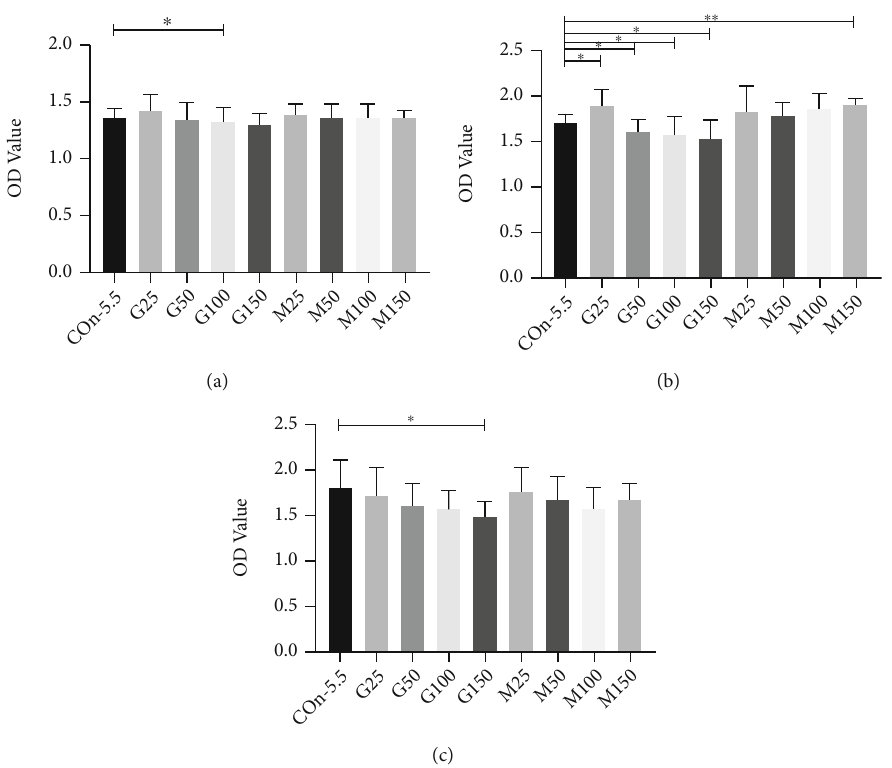
Figure 5: Cell viability of RCGs by the CCK-8 assay. Compared to the control group, the OD value was signi fi cantly lower in the G50, G100, and G150 at 48 h. (a – c) Cell proliferation ability in RGCs treated with di ff erent groups at 24, 48, and 72h. Con-5.5, G25-G150: concentration of glucose (5.5, 25, 50, 100, and 150 mmol/l, respectively); M25-M150: concentration of M-mannitol (19.5, 44.5, 94.5, and 133.5mmol/l, respectively). ∗ p < 0 : 05 ; ∗∗ p < 0 : 01 . RGCs: retinal ganglion cells CCK-8: Cell Counting Kit-8 assay OD value: optical density value. by immuno fl uorescence staining at 48 h. The proportion of